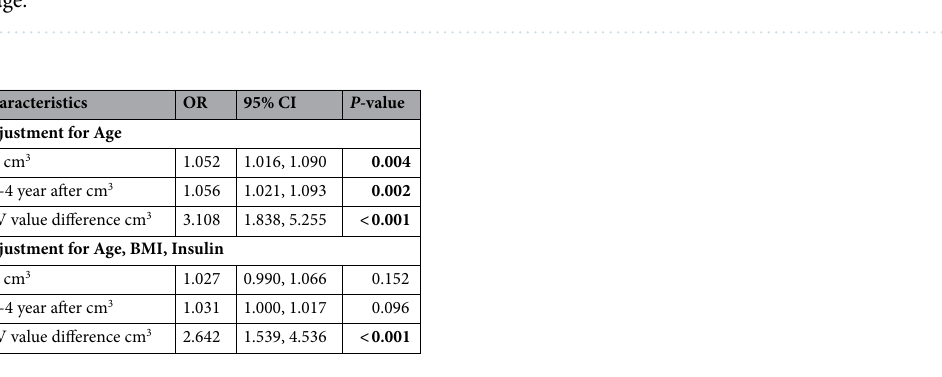
Table 3. Associations of Low testosterone and PV levels after 4 years. *PV value difference, PV-4 year after subtract PV.